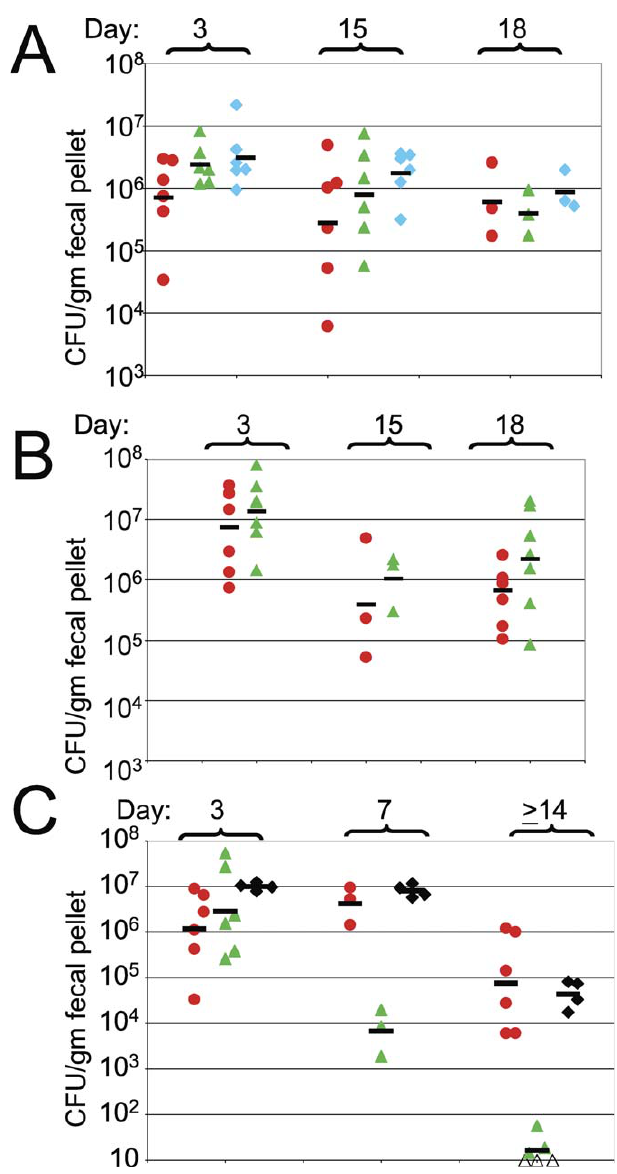
Figure 6. rbt1 and rbt4 Mutants Colonize the Murine Intestinal Tract at WT Levels Cells of WT strains DAY185 or F2U, rbt1 deletion mutant strain BCa 7–4, rbt4 null mutant strain BCa 11–3, ece1 null mutant CAW19–1, CKY362 ( ECE1 reconstituted), and CKY376 ( yhb1 yhb5 double null mutant) were orally inoculated by gavage. At various days post-inoculation, fresh fecal pellets were recovered from inoculated mice and the amount of C. albicans per gm was measured. Composite results of two experiments are shown. Different numbers of mice are shown on different days because some mice were sacrificed earlier and some mice were sampled on different days. (A) Red circles, DAY185 or F2U (WT) (six mice); green triangles, rbt1 deletion mutant strain BCa 7–4 (six mice); blue diamonds, rbt4 deletion mutant strain Bca 11–3 (six mice); bars, geometric means. (B) Red circles, DAY185 (WT) (six mice); green triangles, yhb1 yhb5 double null mutant strain CKY376 (six mice); bars, geometric means. (C) Red circles, DAY185 or F2U (WT) (six mice); green triangles, ece1 deletion mutant strain CAW19–1 (six mice); black diamonds, ECE1 reconstituted mutant strain CKY362 (four mice); bars, geometric means. Open symbols, no colonies detected. Day (cid:3) 14 indicates samples taken on day 14 or day 15.